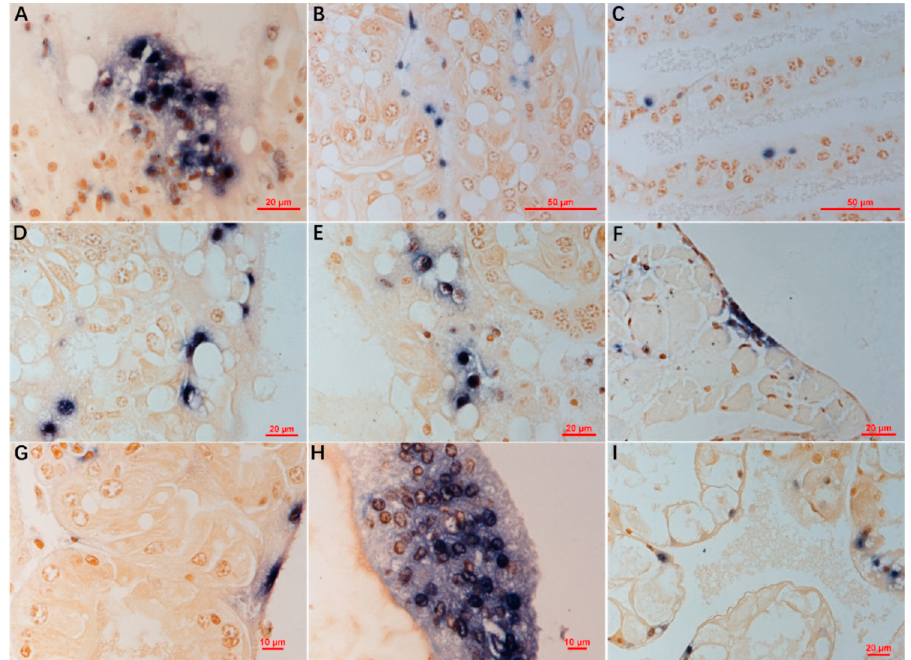
Figure 3. In situ digoxigenin-labeled loop-mediated isothermal amplification (ISDL) targeting the gene of the second largest subunit of DNA-directed RNA polymerase II of DIV1 on histological sections of M. rosenbergii ( A – F ), M. nipponense ( G ), and Pr. clarkii ( H , I ) samples 20180620. ( A , H ) Hematopoietic tissue; ( B , D , G , I ) hepatopancreas; ( C) gills; ( E ) antennal gland; ( F ) ovaries. In A–C, and H, blue signals were observed in hematopoietic tissue, hemocytes in the sinus of the hepatopancreas, and in gills. In D, G, and I, blue signals exist in some hepatopancreatic R-cells and myoepithelial fibers. In E, blue signals exist in the coelomosac epithelium. In F, blue signals exist in the epithelium. Bar, 20 μ m (A, D–F, and I), 50 μ m (B and C), and 10 μ m (G and H), respectively.